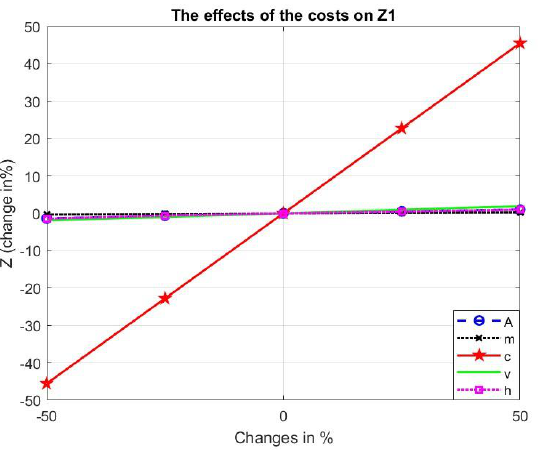
Figure 5. The effects of the costs of the numerical example on the total cost of the first model.